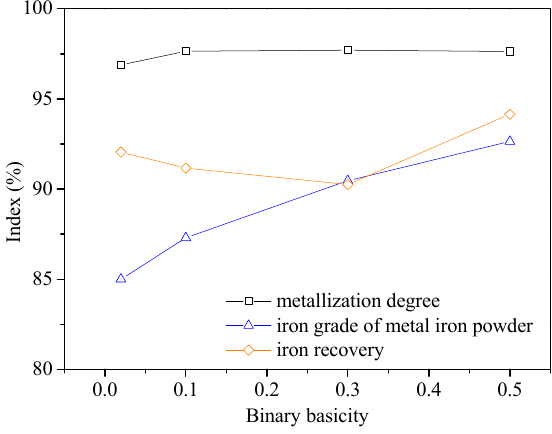
Figure 12. Effect of binary basicity on the reduction and separation indexes (reducing at 1350 °C for 25 min with a total C/Fe mass ratio of 1.0, 15% coal blended in pellets).